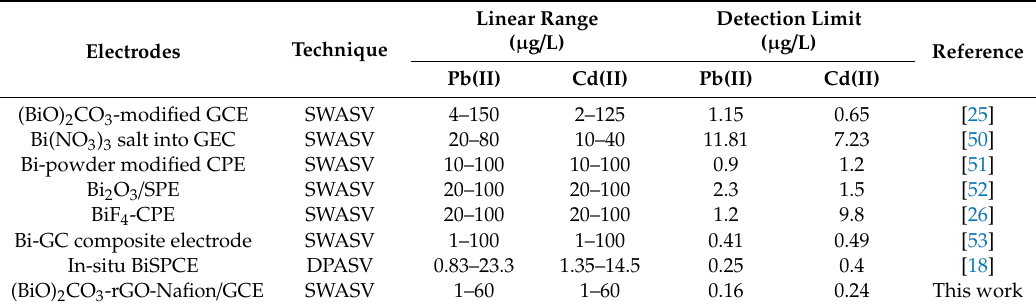
Figure 8. ( A ) Square wave anodic stripping voltammograms for additions of 1, 5, 10, 15, 20, 25, 30, 35, 40, 45, 50, 55 and 60 µ g / L Cd(II) and Pb(II). The right part of the figure shows the calibration curves for ( B ) Cd(II) and ( C ) Pb(II). Table 1. Comparison of di ff erent sensors used in the detection of Pb(II) and